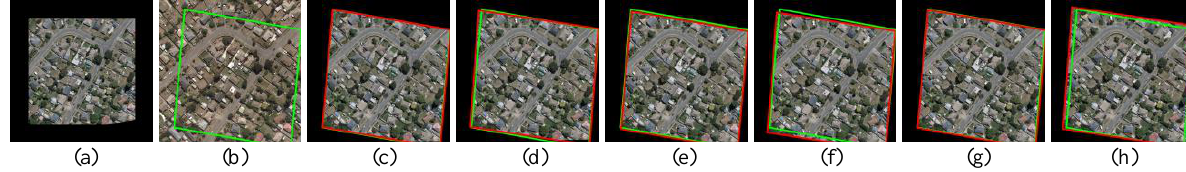
Figure 6. Registration Result of an image pair in Optical-Optical dataset. (a) Randomly affine transformed and cropped sensed image. (b) Reference image. (c) MU-Net. (d) SIFT. (e) RIFT. (f) CFOG. (g) DLKFM. (h) DLIR. The green line represents the ground truth registration result, and the red line represents the experimental registration result for each method.